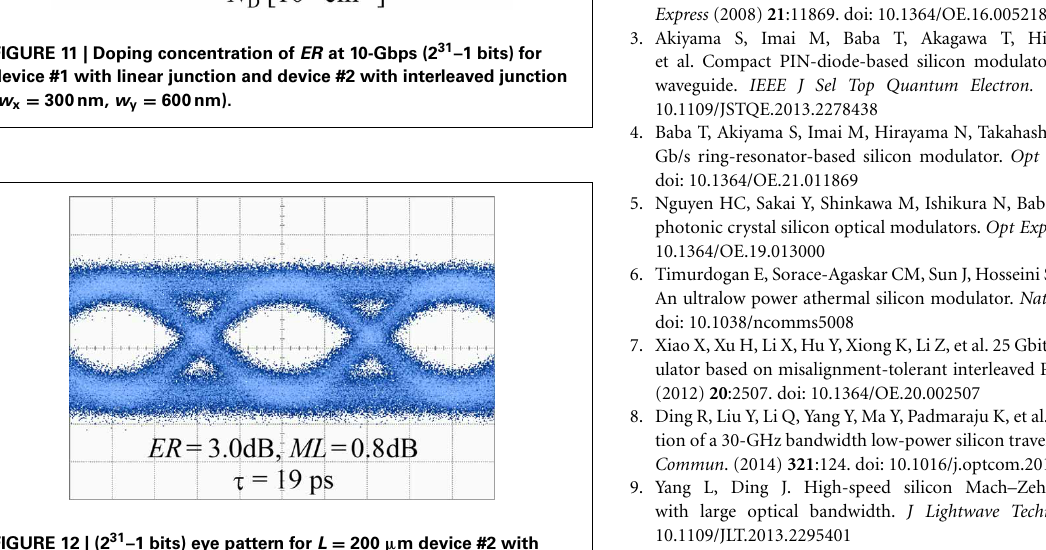
FIGURE 12 | (2 31 –1 bits) eye pattern for L = 200 µ m device #2 with interleaved junction ( w y = 600nm) and high doping concentration. V pp = 1 . 75V and V DC = − 0 . 90V. In this measurement, higher–speed pulse pattern generator (Anritsu 183021A; the measurement τ R is 11 ps) was